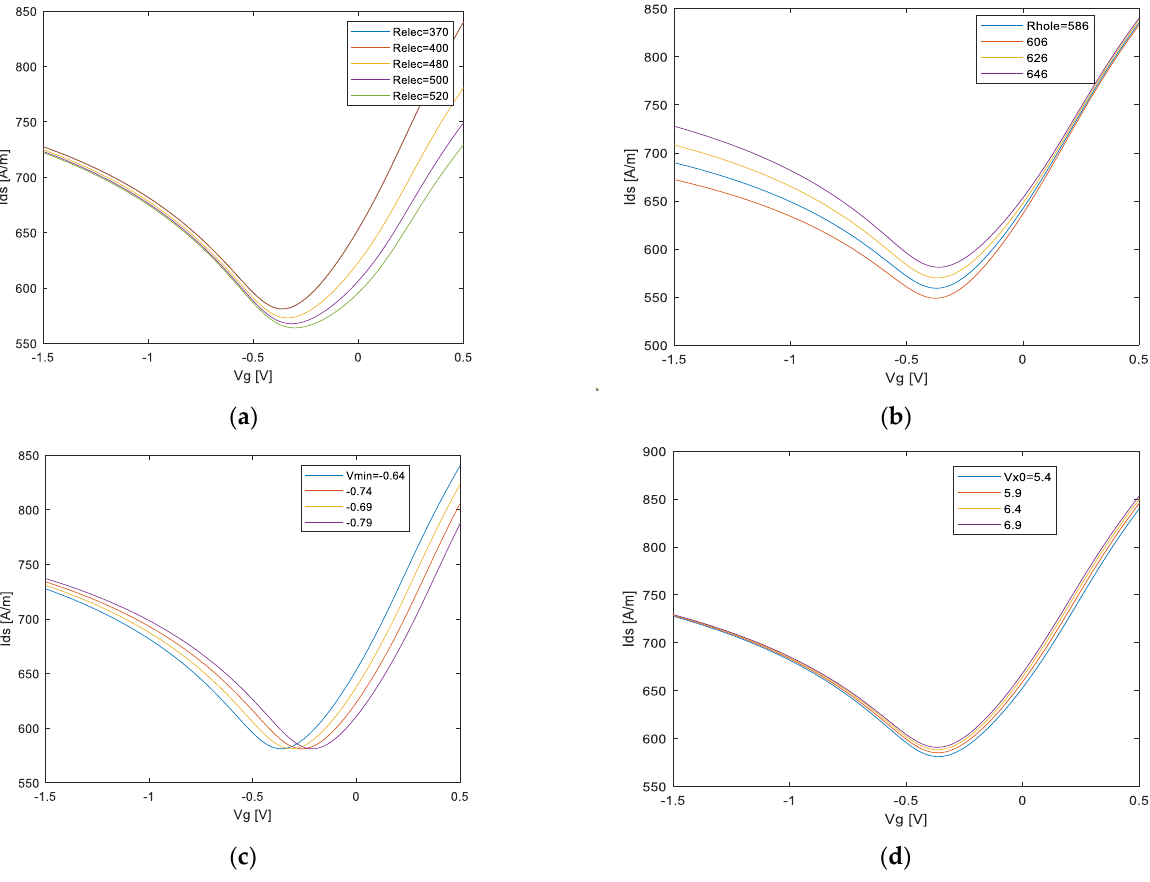
Figure 11. Schematic illustration of different parameter effects of AVS model. (𝐚) 𝑅 𝑒𝑙𝑒𝑐 , (𝐛) 𝑅 ℎ𝑜𝑙𝑒 , (𝐜) 𝑉 𝑚𝑖𝑛0 , (𝐝) and 𝑣 𝑥0 .